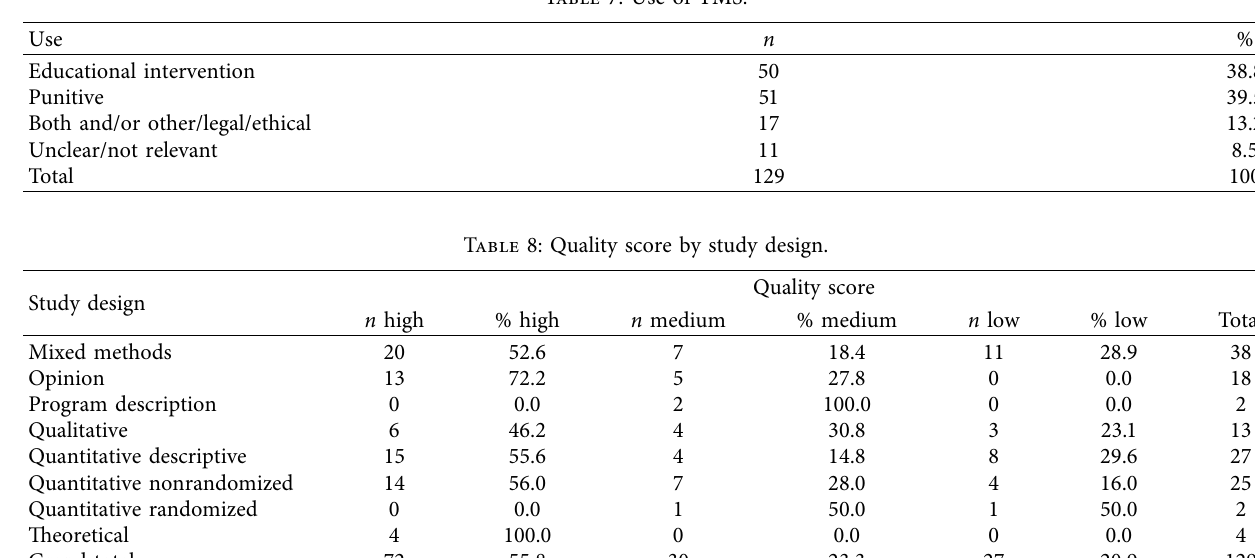
Table 7: Use of TMS.